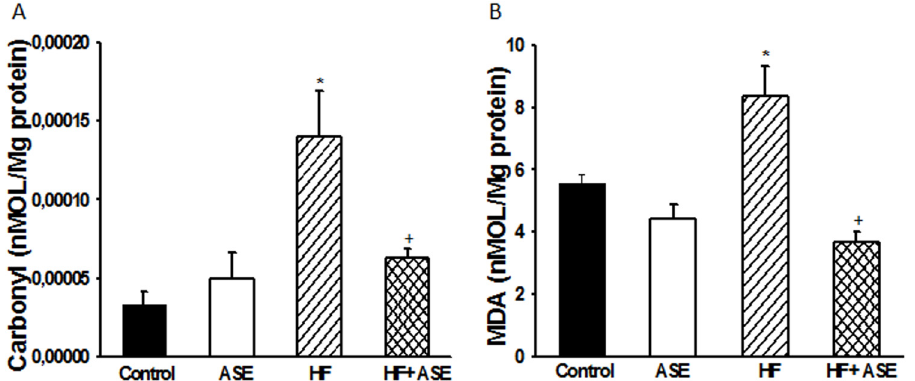
Fig 7. Protein carbonylation and malondialdehyde levels. Effects of ASE on protein carbonylation (A) and malondialdehyde levels (B) in liver from HF fed mice. Values are means ± SEM, n = 8 for all groups. * Significantly different from the control and ASE groups (p (cid:1) .05). + Significantly different from the corresponding HF group (p (cid:1)